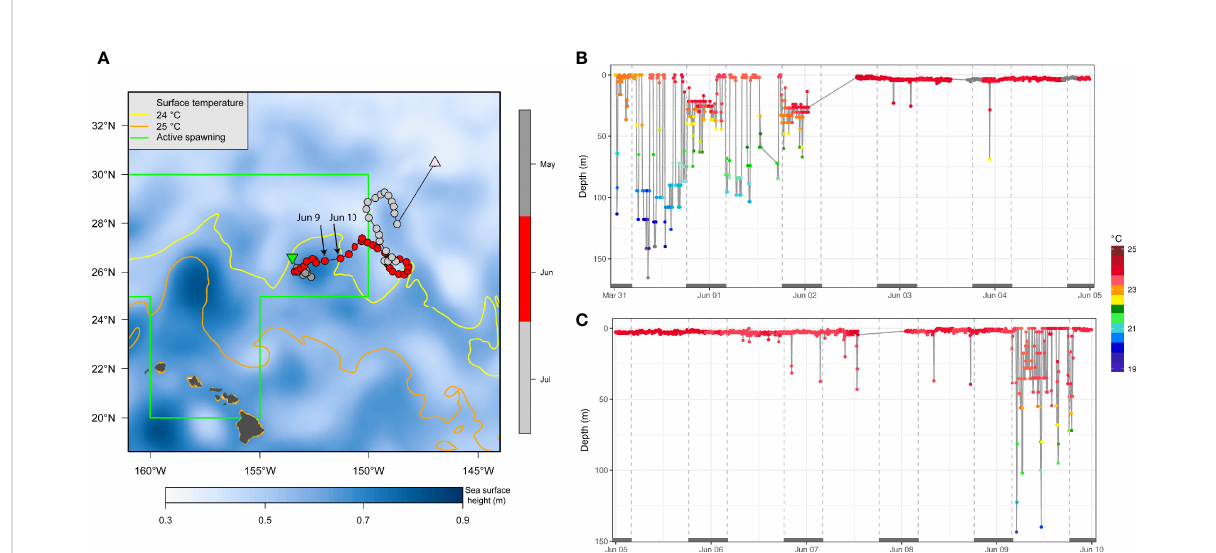
FIGURE 7 Oceanographic setting (A) and swimming depth-temperature time series (B, C) of striped marlin PG14 in early June. In (A) , sea surface height is plotted as false-color, and surface temperature isotherms at 24°C (yellow) and 25°C (orange) are contoured, using monthly data of June 2018 from GLOBAL_REANALYSIS_PHY_001_030 product of the Copernicus Marine Service Global Monitoring and Forecasting Centre. Positions are color-coded by month. The area depicting location of sampled active female spawners (Humphreys and Brodziak, 2019) during the spawning season (May-August) is outlined in green. In (B, C) , when temperature values were not received through the Argos satellites, corresponding depth values are shown in grey. Grey bars on the x-axis (date scale) denote